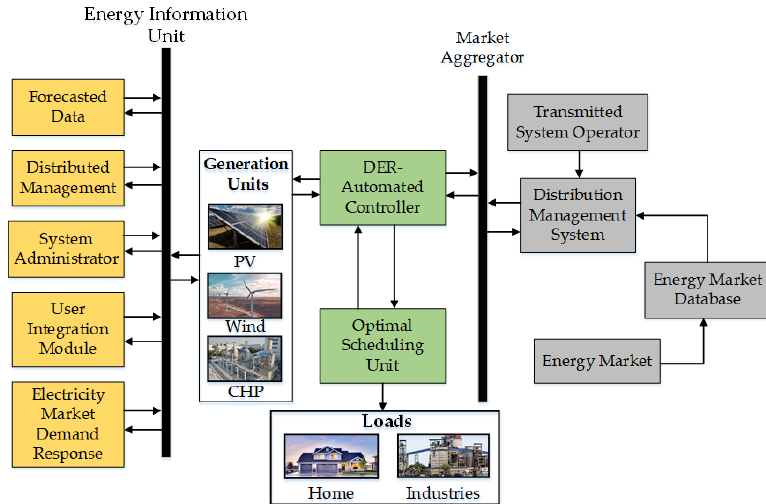
Figure 14. A schematic representation of virtual power plants considering the demand side management or operational scheduling of loads. (Note: PV-photovoltaics; DER-distributed energy resources; CHP-combined heat and power).